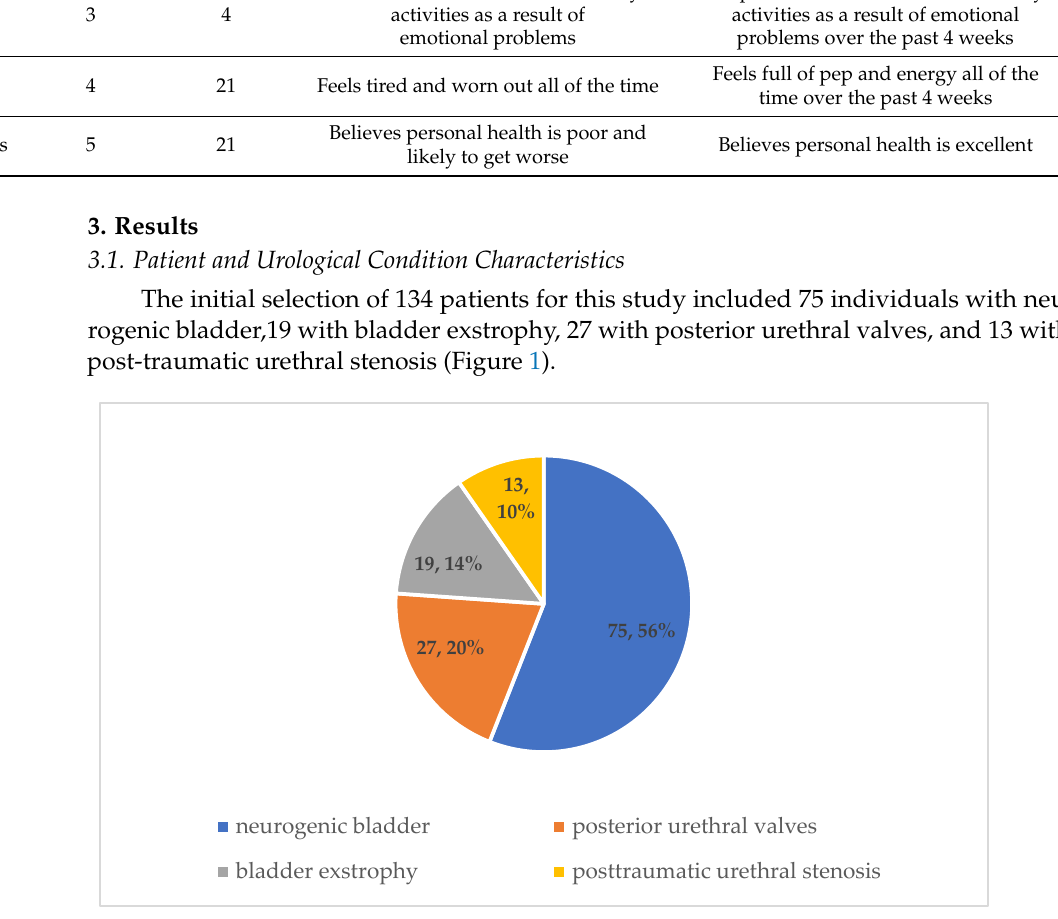
Figure 1. Distribution of pathologies that may require a continent urinary diversion.